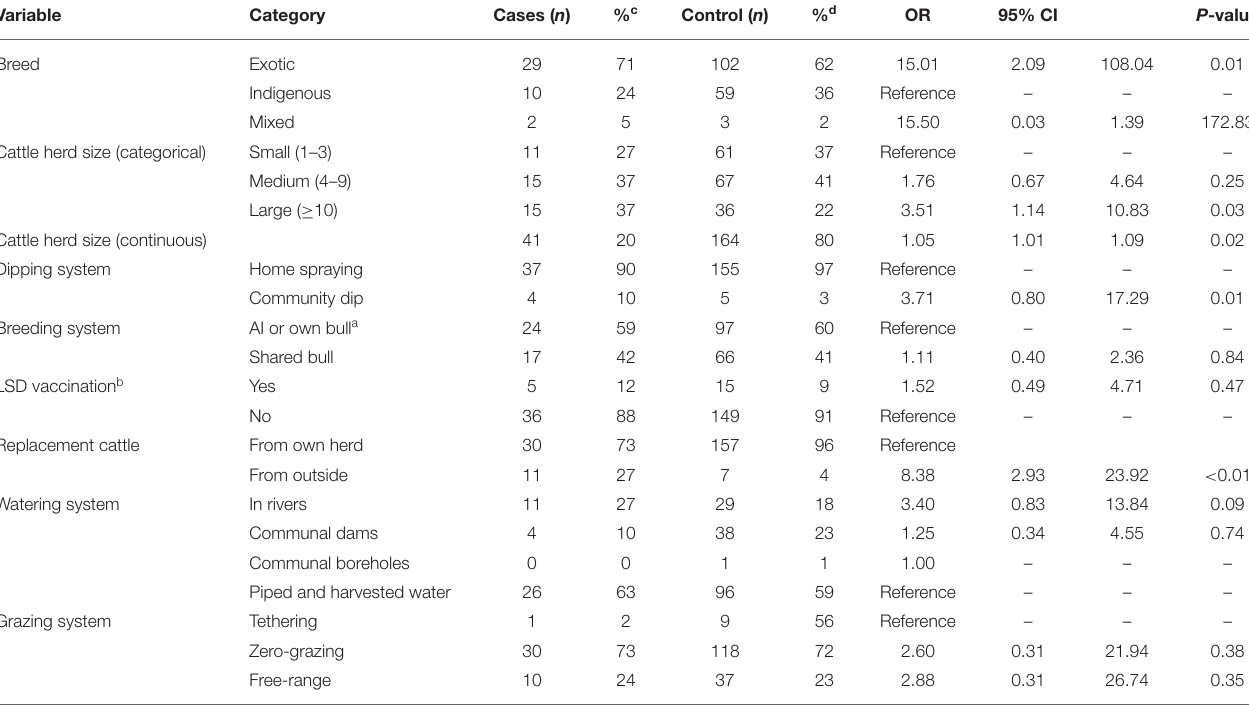
TABLE 1 | Univariable analysis of household-level putative risk factors for Lumpy Skin Disease in Nakuru County, Kenya. Variable